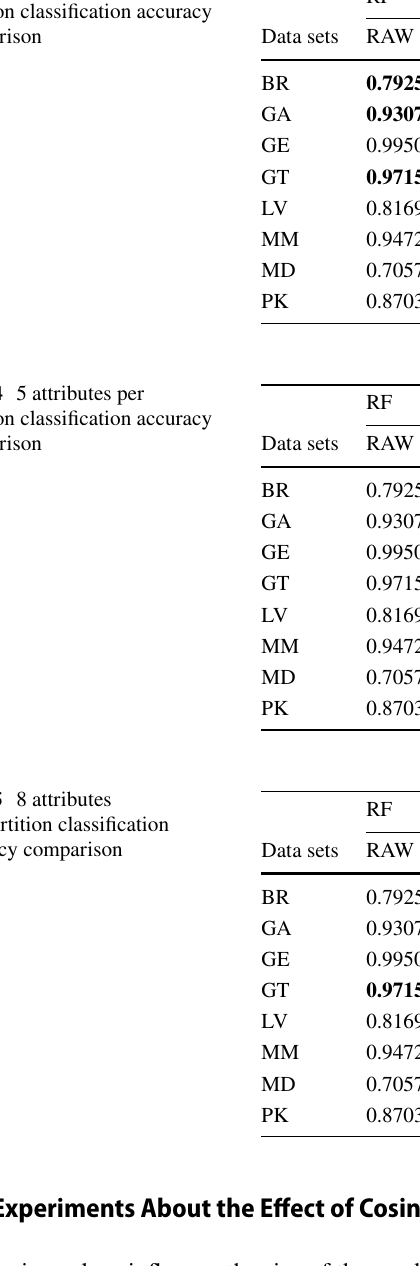
partition classification accuracy comparison